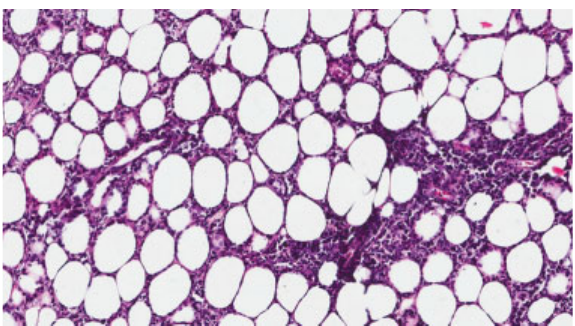
Fig. 2 Hematoxylin and eosin staining (extension (cid:1) 200). Skin biopsy showingsubcutaneous tissue with neoplastic in fi ltrate. The neoplastic cells range in size and have irregular, hyperchromatic nuclei. The characteristic feature is the rimming of the neoplastic cells surrounding individual fat